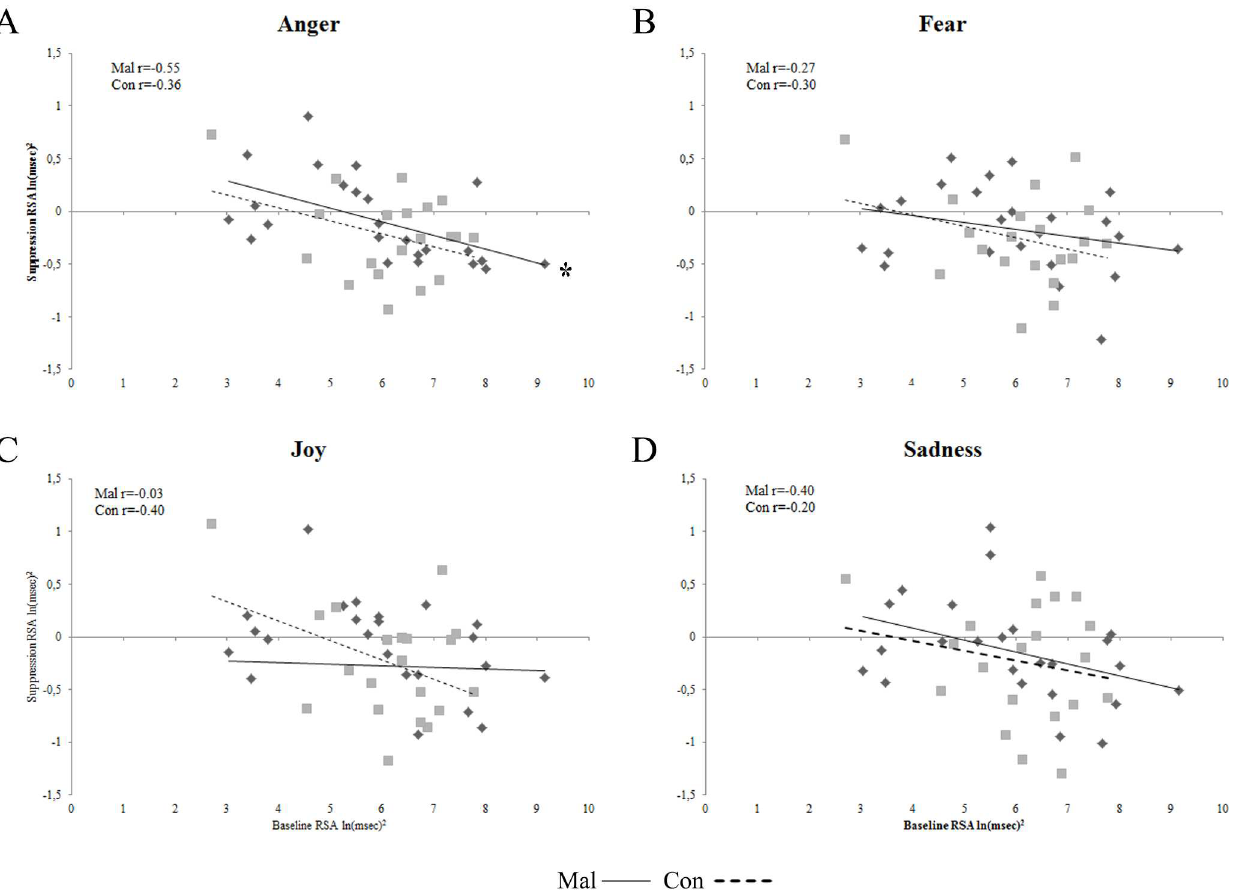
Fig 3. Correlation plots between baseline and suppression RSA values in the two groups. Plots of correlations between baseline and suppression RSA values for maltreated children (Mal) and controls (Con) displayed emotion by emotion. * = Bonferroni corrected p <